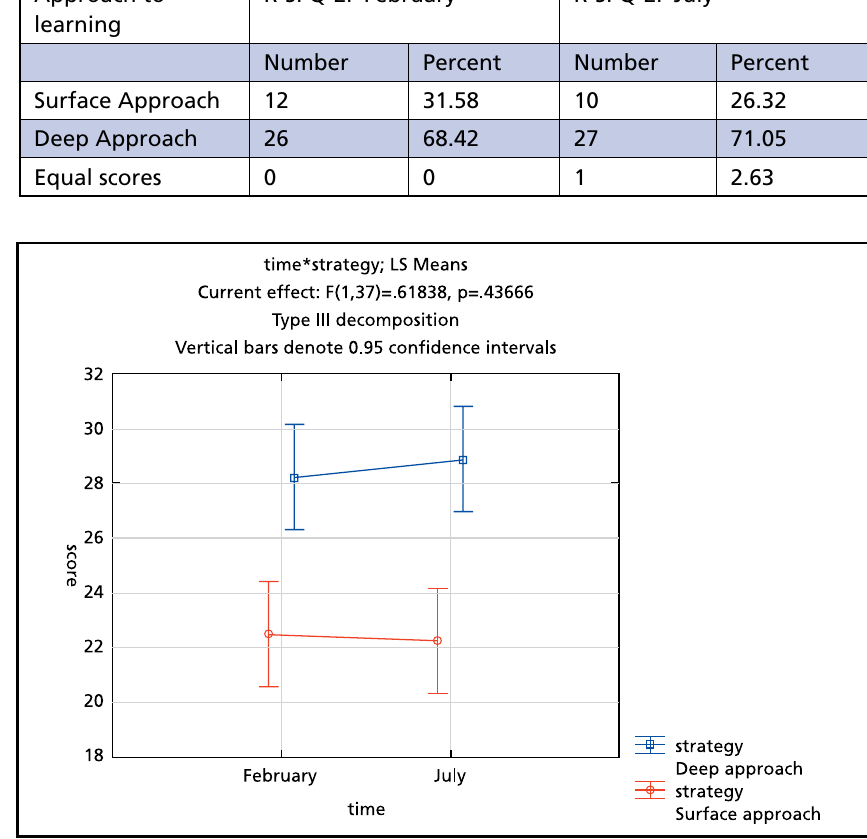
Figure 1: Deep versus surface approach over